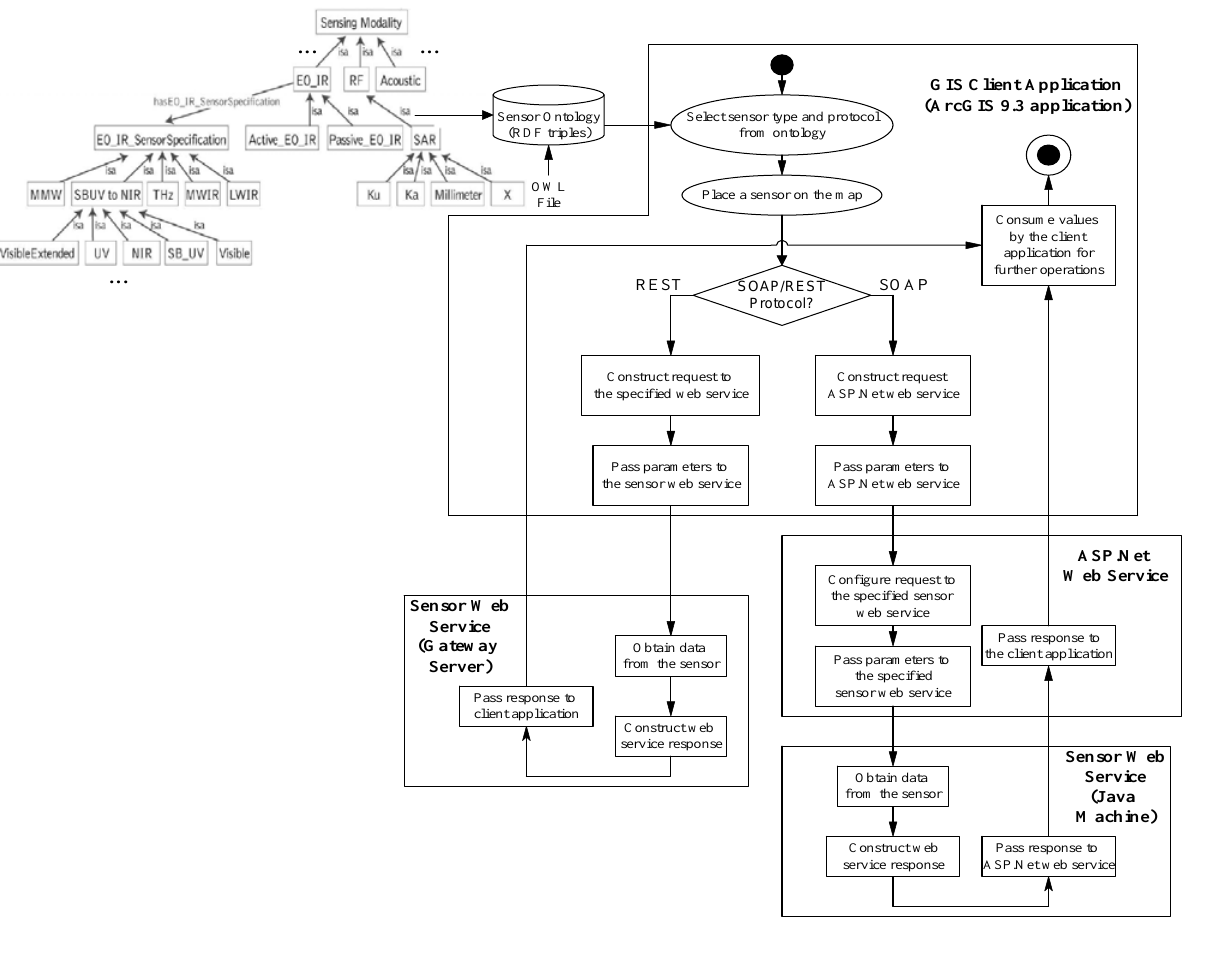
Figure 6. Web services command workflow associated with GIS sensor placement.